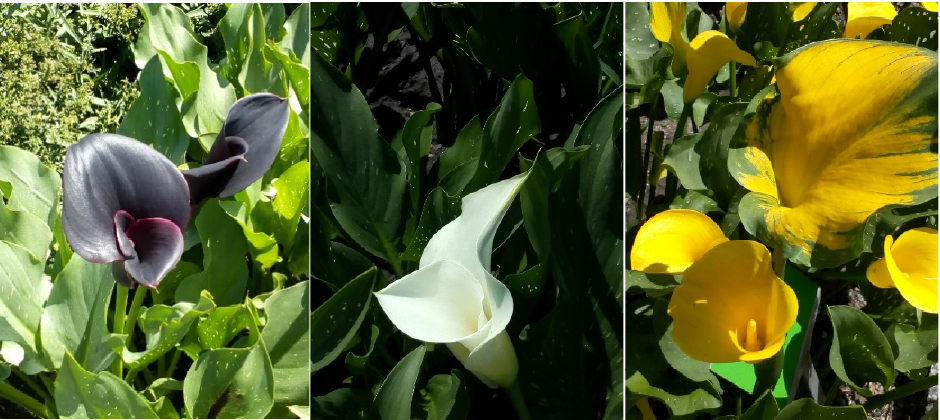
Figure 5 . Inflorescence deformities in Zantedeschia (Beata Janowska 2017).